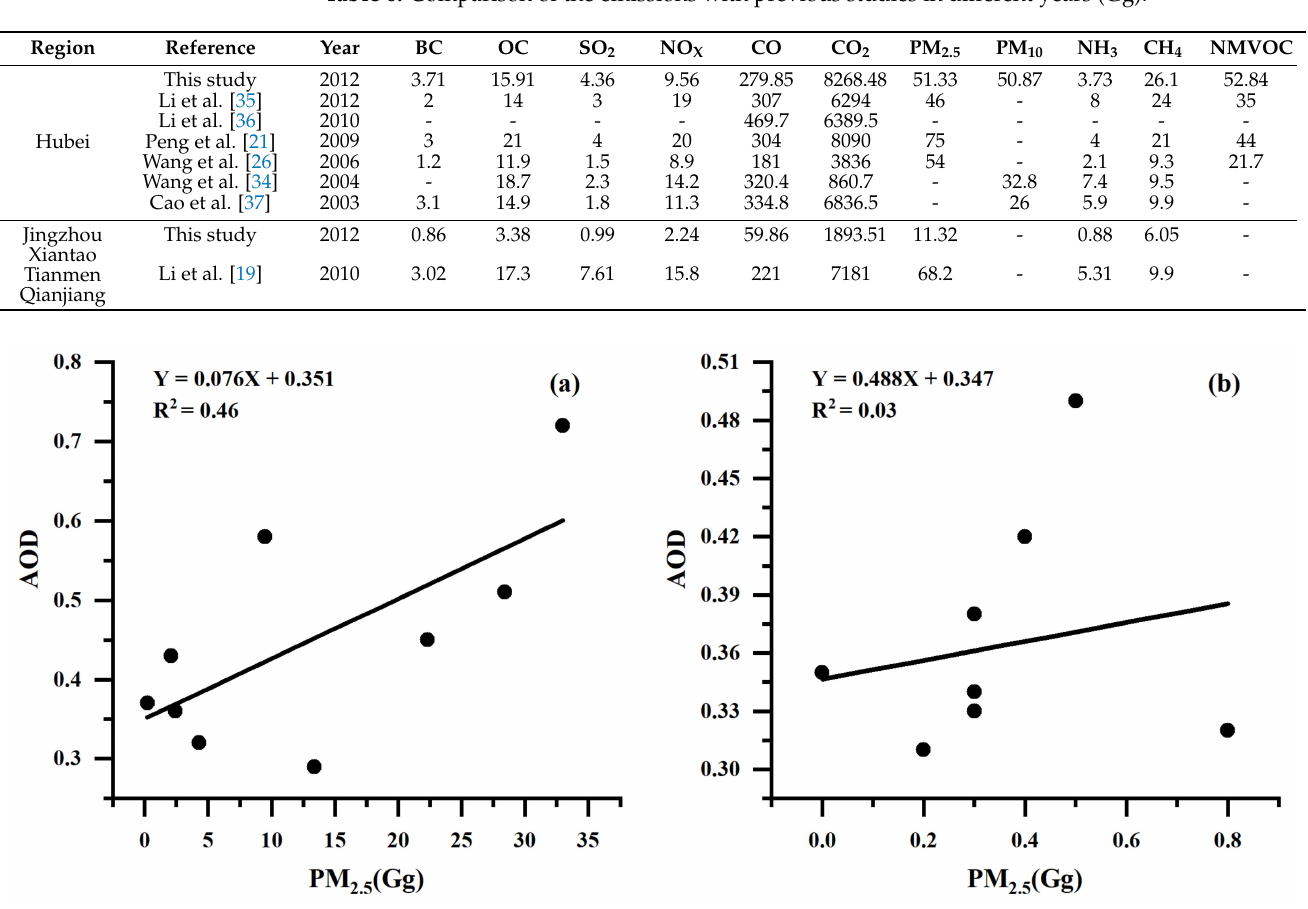
Figure 8. Comparison of PM 2.5 emissions with AOD during the straw burning season ( a ) and non-straw burning season ( b ) during